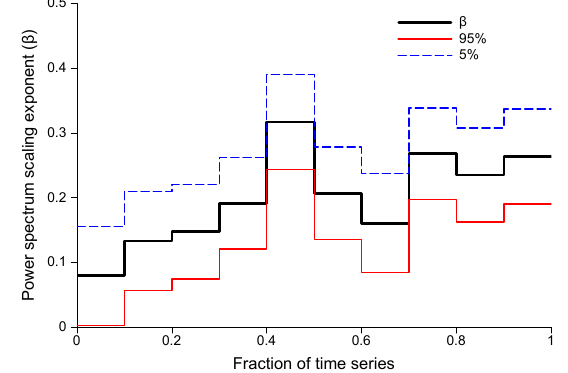
Fig. 3. Temporal variability of the power spectrum scaling exponent ( β ) for Brandon daily snowfall over the period 1895 to 2003, deter- mined by dividing the time series into 10 sections of equal length. The 5% and 95% confidence levels of β are also plotted for each